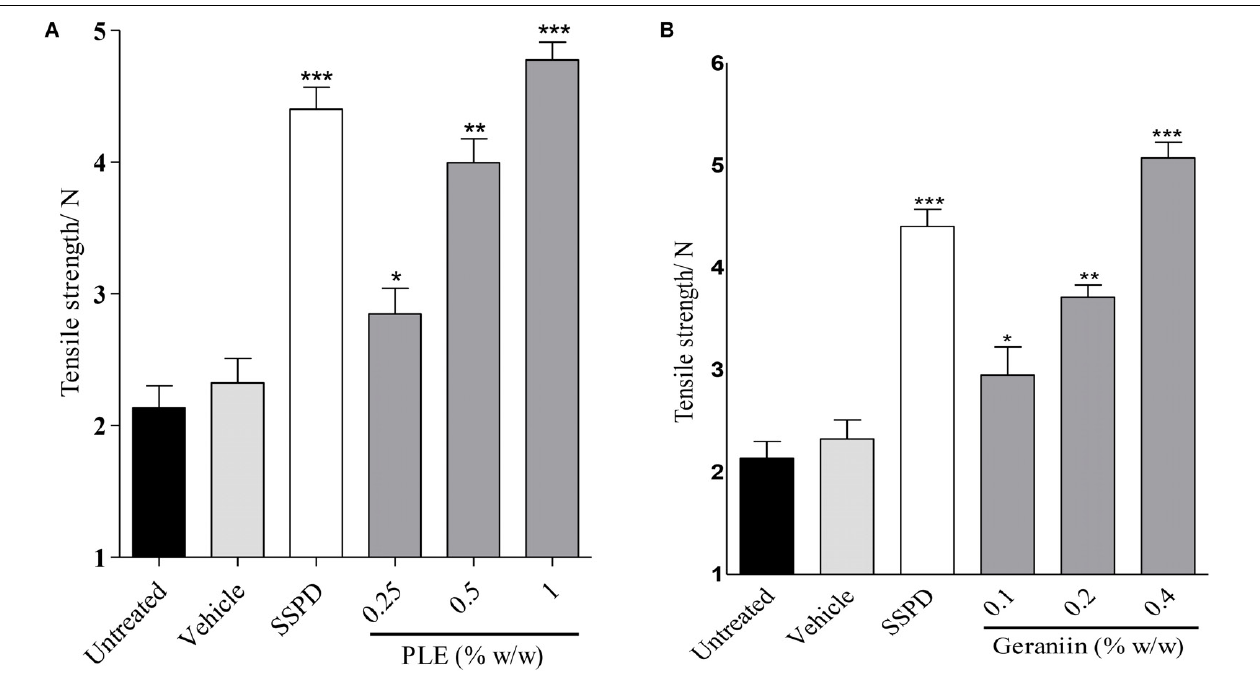
FIGURE 7 | Influence of PLE (A) and geraniin (B) on tensile strength of incised wound tissue. Paravertebral incisions were made through the full thickness of the skin on each side of the vertebral column and sutured. The sutured wounds were treated with PLE (0.25, 0.5, and 1% w/w) and geraniin (0.1, 0.2, and 0.4% w/w) and tensile strength determined on 10 days post incision. PLE, aqueous extract of the aerial parts of P. muellerianus ; SSPD, 1% silver sulphadiazine-treated wound tissues. Vehicle group was treated with aqueous cream base only. Values are mean ± SEM, n = 5. ∗∗∗ p < 0.001; ∗∗ p < 0.01; ∗ p < 0.05 compared to untreated group (one-way ANOVA followed by Dunnett’s post hoc